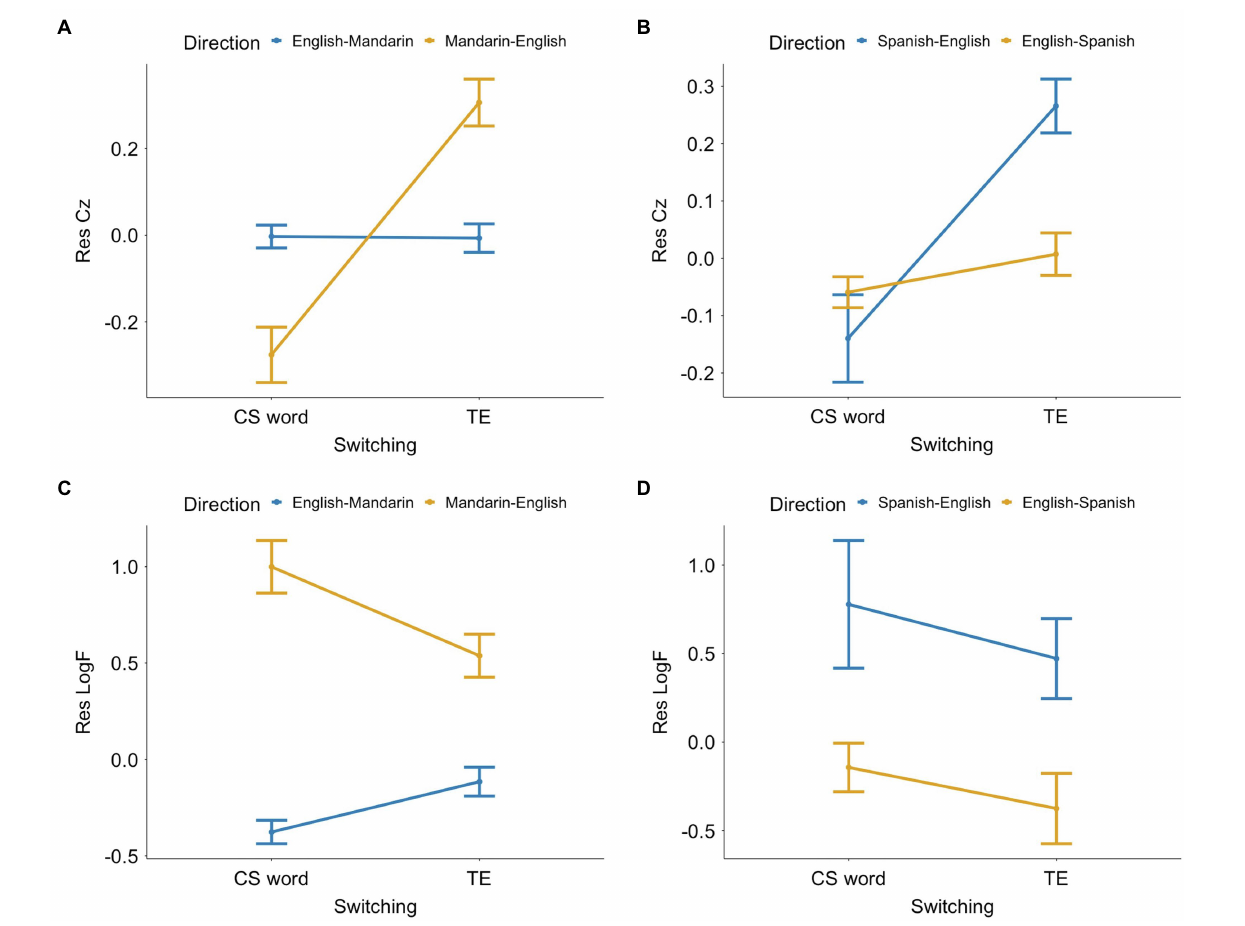
FIGURE 5 | Means for switching and CS-TE direction of the residualized standardized clustering coefficients (Res C Z ) for (A) the Mandarin-English corpus and (B) the Spanish-English corpus, and the residualized log-transformed frequencies (Res LogF ) for (C) the Mandarin-English corpus and (D) the Spanish-English corpus. The error bars represent the 95% confidence